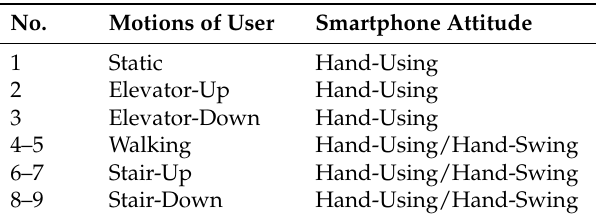
Table 1. The definition of multi-floor motions.